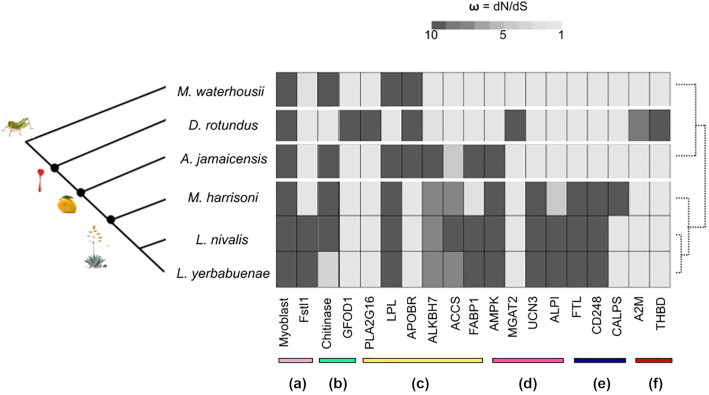
Positive selection in genes and proteins across the phylogeny of Phyllostomid bats, in comparison to the insect-feeding bat Macrotus waterhousii. Most of the positive selected genes likely contribute to the regulation and processing of (a) muscle and bone development, (b) carbohydrates, (c) lipids, (d) nutrients and food uptake, (e) iron storage and calcium sources, and (f) blood regulation (see gene and protein abbreviations in Supplementary Table S14).